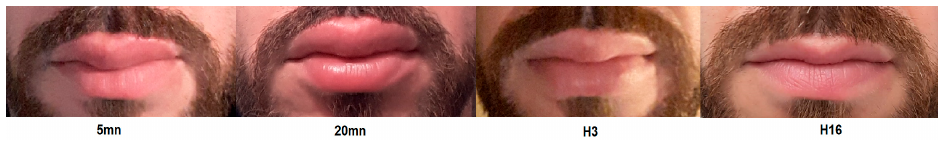
Figure 1. Labial angioedema evolution during COVID-19, from 5 mn to H16.